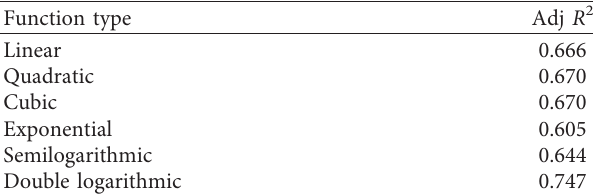
Table 1: Boarding time models and performances.